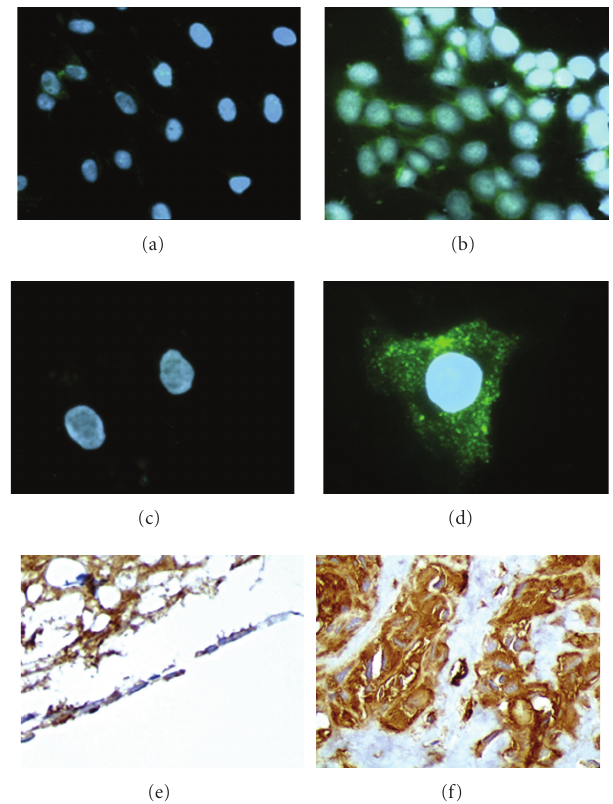
Figure 5: Indirect immunofluorescence staining and immunohis- tochemistry were performed with the selected Fabs. Methanol-fixed fibroblasts ((a) and (c)) or U2-OS osteosarcoma cells ((b) and (d)) were stained with Fab N-H7 ((a) and (b)) or Fab O-G11 ((c) and (d)). Fab O-G11 was also used to stain to normal bone (e) (200x) and osteosarcoma tissue (f) (400x) sections. The osteoblasts in normal bone are arranged in lines; the empty region corresponds to bone trabecules dislocated during washing. These results are representative from four di ff erent osteosarcoma cases